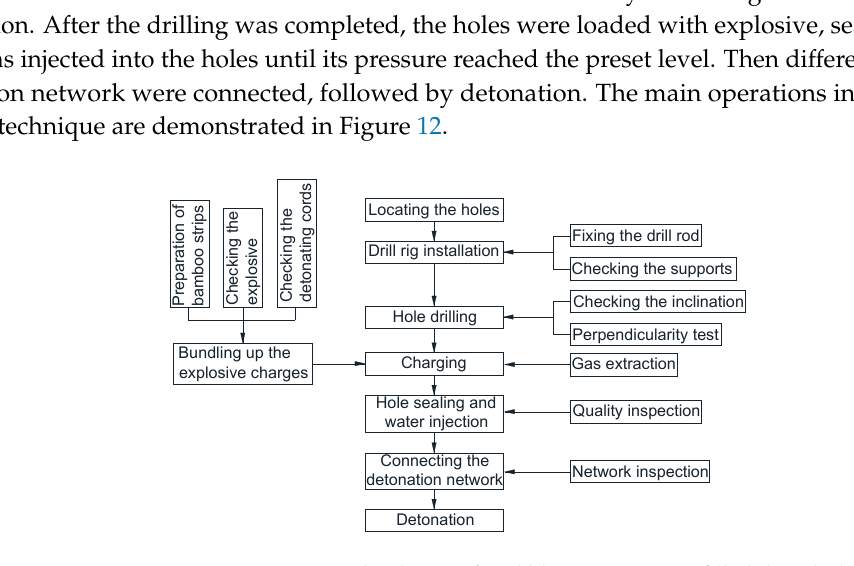
Figure 12. Main operations involved in confined blasting in water-filled deep holes.